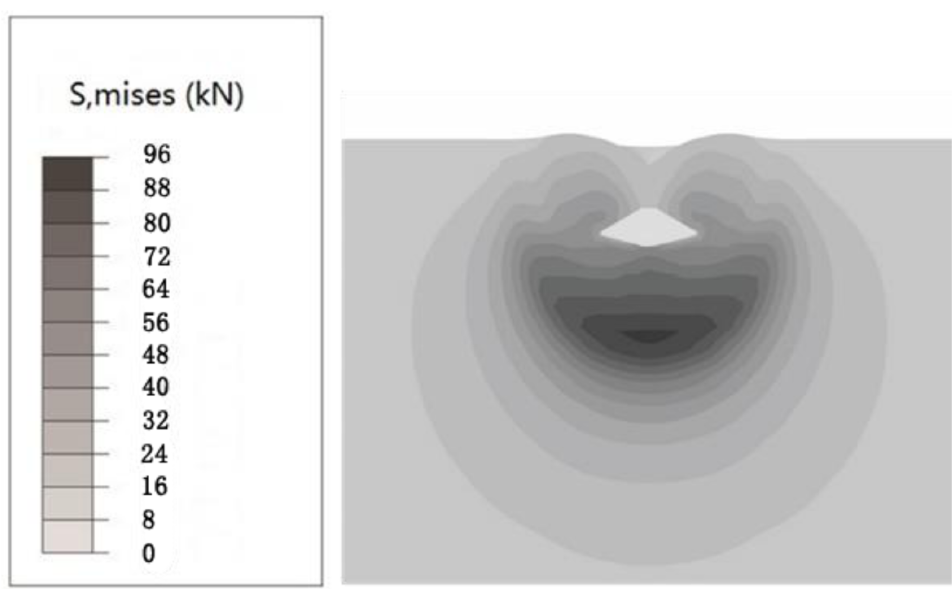
Figure 4. Initial stress field of the small-strain Lagrangian analyses.